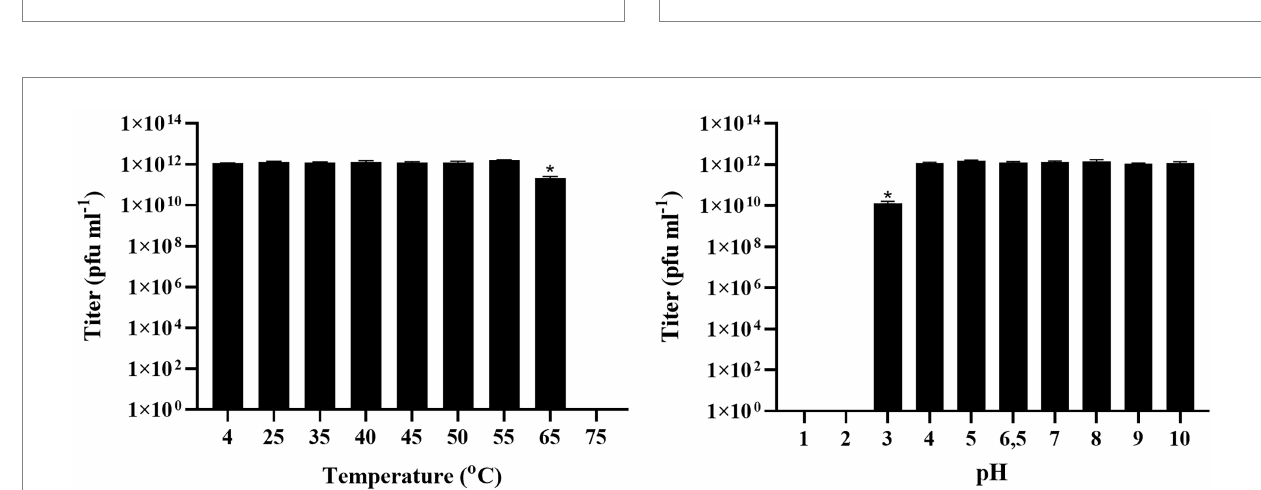
FIGURE 8 One-step growth curve of Tenacibaculum phage Larrie against host strain LAR25 at multiplicity of infection (MOI) 0.01. Values are mean ± SD ( n = 3).